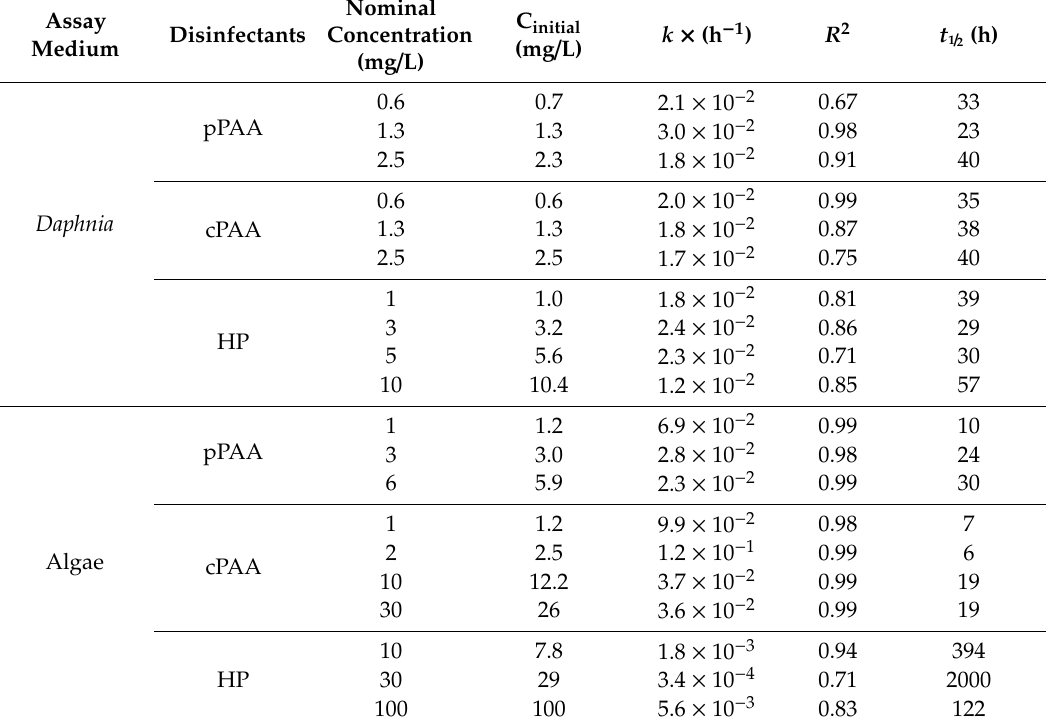
Table 3. Fitted parameters of concentration profiles of pPAA, cPAA, and HP in the D. magna ( n = 4) and algal test media ( n = 5) shown in Figure 1. The latter two are from Chhetri et al. [26,27]. Assay